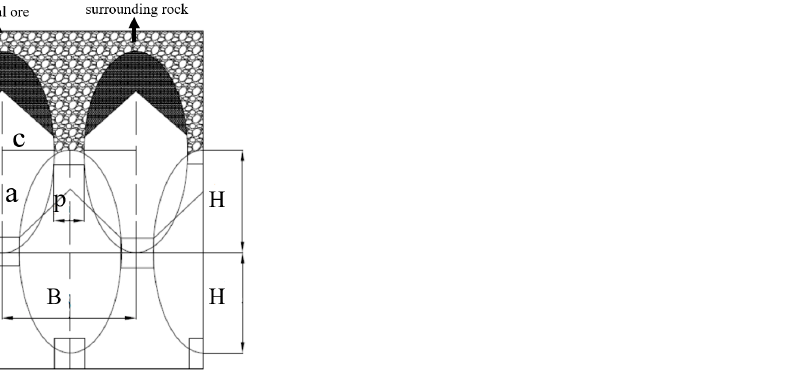
Figure 2. The ellipsoid arrangement is released in the direction of the vertical access.